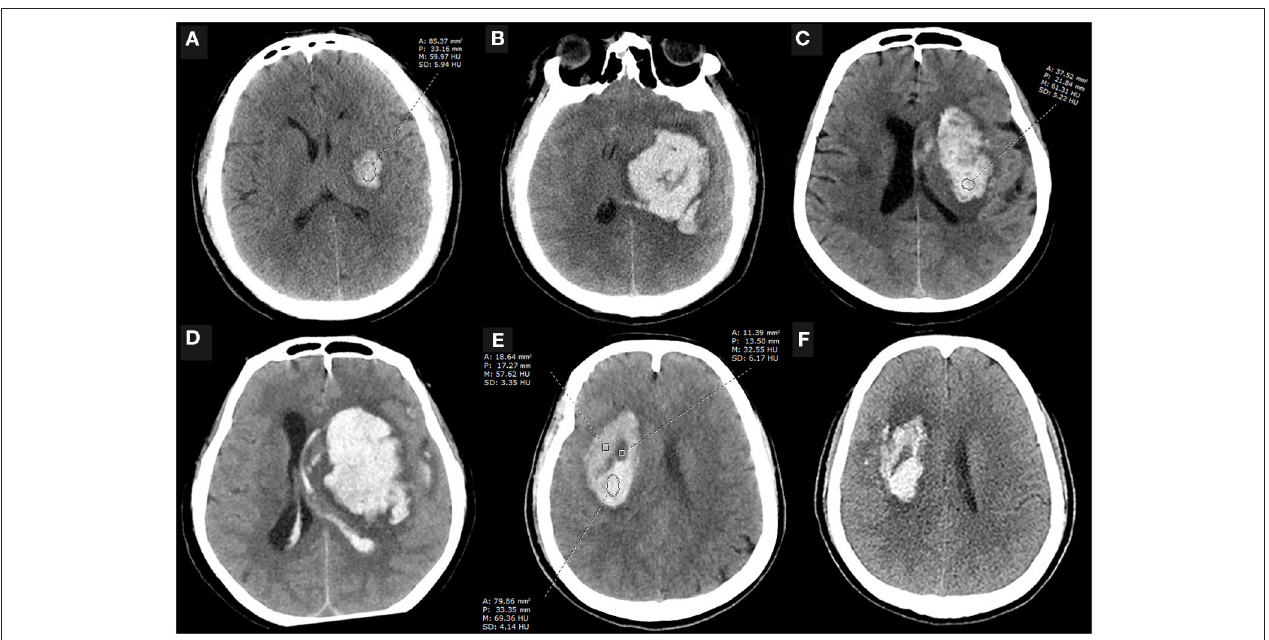
FIGURE 1 | Case examples. (A,B) An initial NCCT scan performed 3.5h after the onset of symptoms showed a small, regular shape hematoma with an attenuation value of 61.72 HU at the internal capsule, which enlarged 10h later. The patient eventually died. (C,D) An NCCT scan performed 0.5h after symptom onset showed a basal ganglia hematoma that was heterogeneous with an attenuation value of 63.86 HU within the non-hypodense region and appeared significantly expansion 12h later. (E,F) NCCT scan performed 1h after onset showed a heterogeneous basal ganglia hematoma with an attenuation value of more than 64 HU in the non-hypodense region, and the patient did not present with HE despite the presence of the black hole sign on the initial NCCT examination. A, area; P, perimeter; M, mean; SD, standard deviance; HU, Hounsfield units; NCCT, non-contrast computed